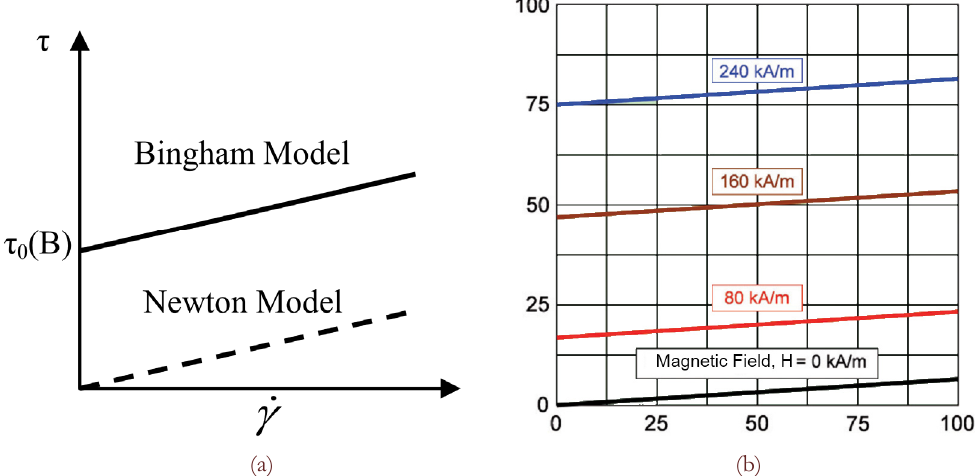
Figure 3: Bingham model of MR fluid (a) and effect of the magnetic field on the yield stress